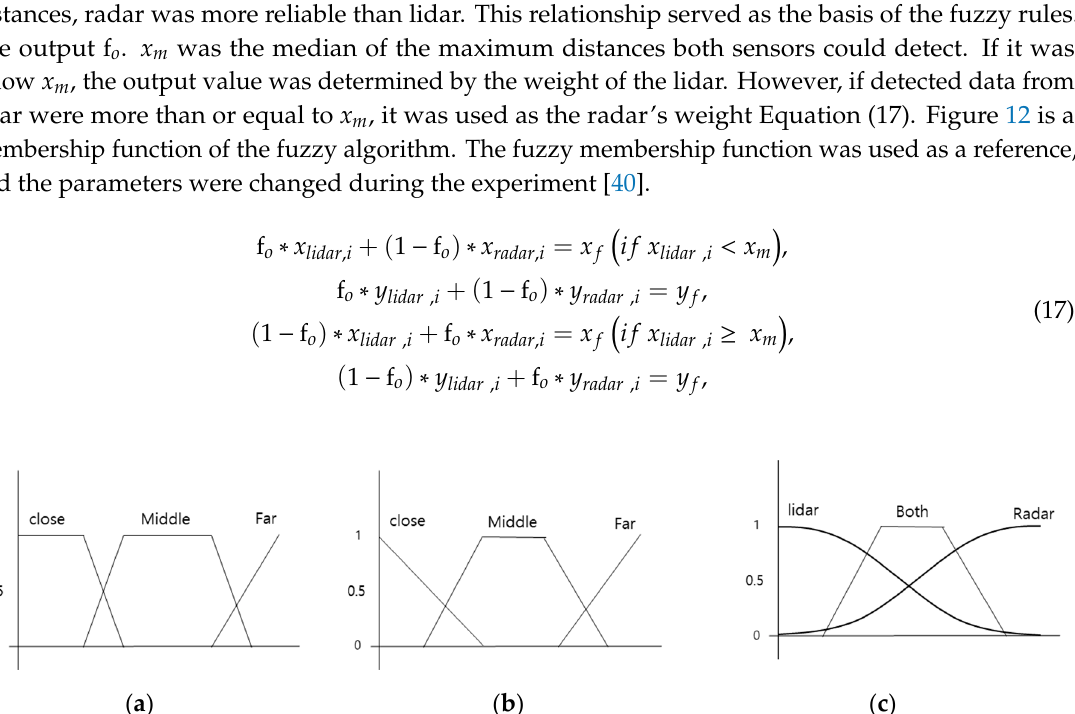
Figure 13. Test vehicle equipped with three lidars, one radar, and a dashboard camera. The measurements used a thin object to maintain the accuracy of the camera and radar’s projection transformation matrix. For these thin objects, the matrix was computed using the image’s x and y ground coordinates, and the radar detection results were projected onto the image coordinate system using the calculated matrix (Figure 14).